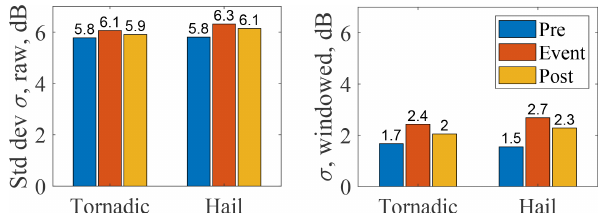
Figure 10. Standard deviation of spectra.